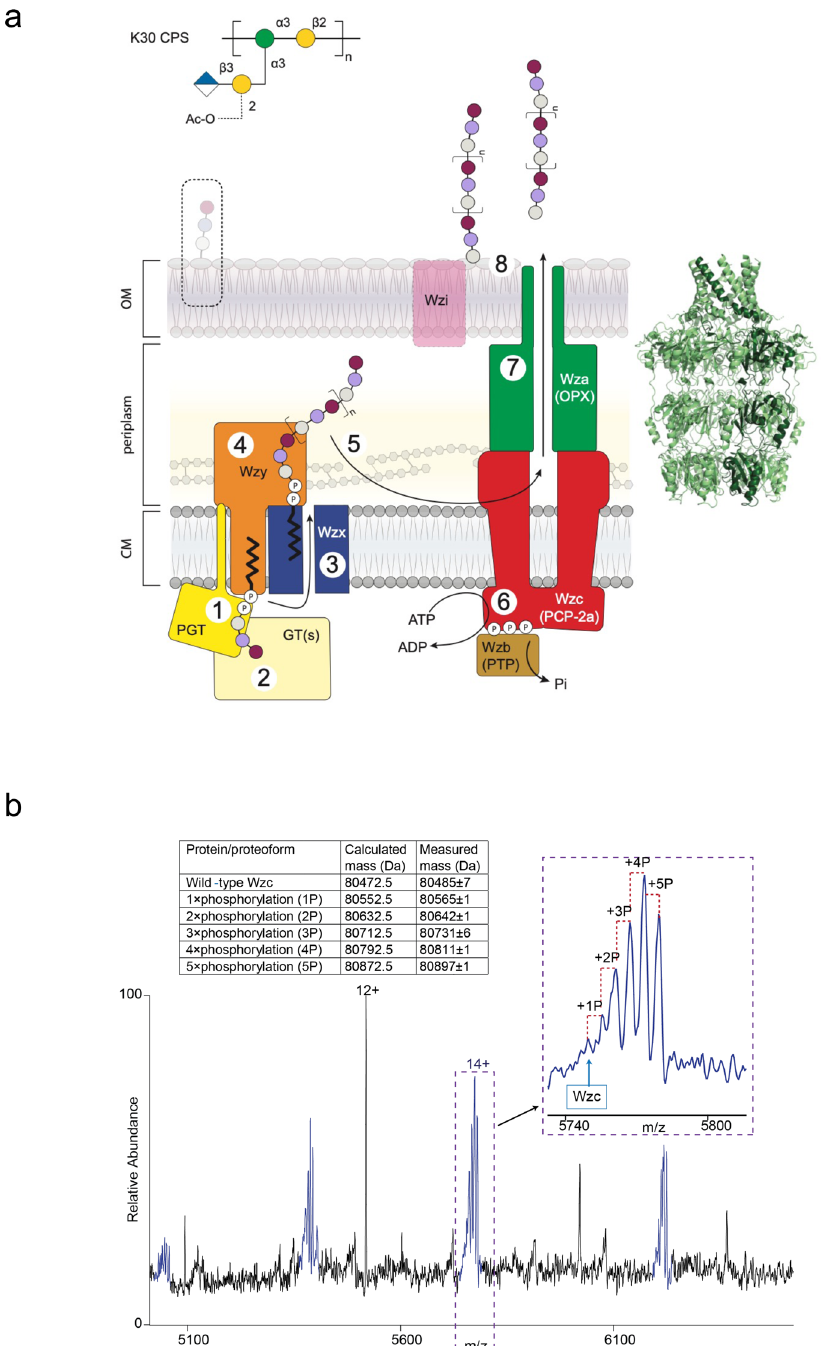
Fig. 1 Capsule assembly and Wzc. a Undecaprenyl diphosphate-linked oligosaccharide repeat units are synthesized by a phosphoglycosyltransferase (PGT; (1)) and serotype-speci fi c glycosyltransferases (GT(s); (2)). These building blocks are fl ipped across the membrane by Wzx (3) and polymerized by Wzy (4) in a reaction regulated by the PCP-2a family autokinase, Wzc. Wzc cycles between phosphorylated and dephosphorylated (catalysed by Wzb) states for its function (6). The polymer is translocated across the outer membrane by Wza (7); the closed octameric structure of Wza 19 is shown on the right. Wza is also regulated by Wzc. In the prototype and some other species, Wzi supports the organization of translocated polymer into the surface-associated capsule structure (8) but this protein is absent from systems that produce secreted EPSs. In Gram-positive, bacteria step (7) is absent and nascent polymer is instead attached to peptidoglycan in the cell wall. In the absence of Wzc or Wza, short oligosaccharides representing one to a few repeat units are incorporated into LPS molecules in an off-pathway reaction (hatched box). The process has recently been reviewed 1,4 . The fi gure has been adapted from 1 . b Puri fi ed, native phosphorylated Wzc appears only as a monomer (peak series highlighted in blue) in native mass spectrometry. The 14 + charge state shows multiple phosphorylation (denoted P) states of Wzc with four sites being the most prevalent (inset). The theoretical and measured masses for all the observed species are shown in the table. Supplementary Fig. 2a identi fi es phosphopeptides. The peak series with a measured mass of 66,212 ± 2 Da was a contaminant protein.